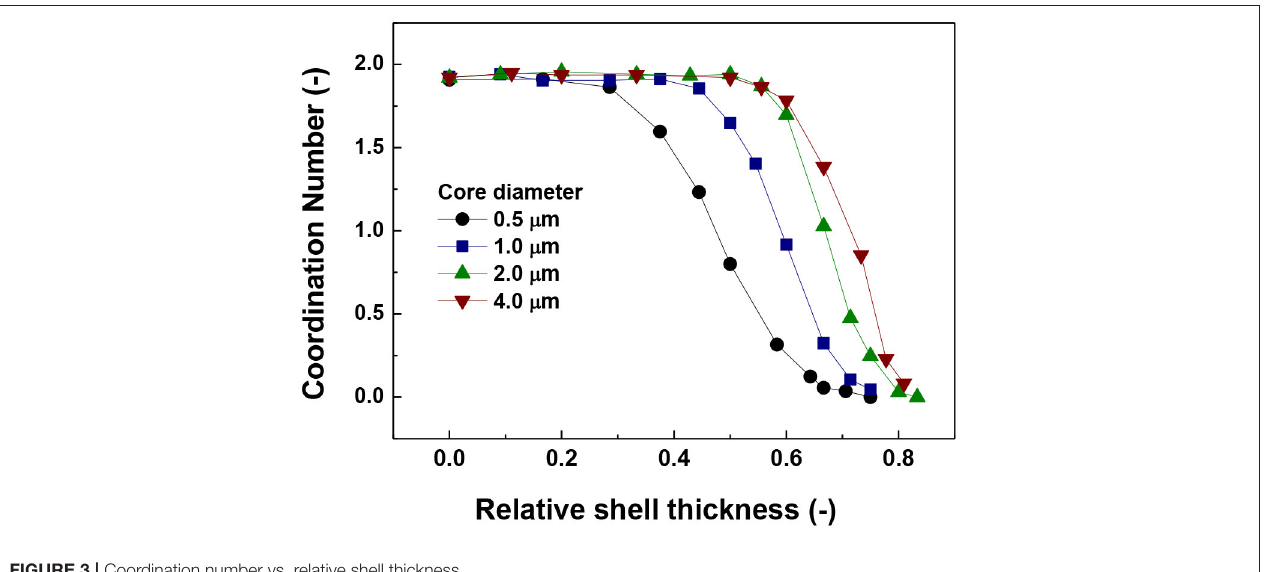
FIGURE 3 | Coordination number vs. relative shell thickness.